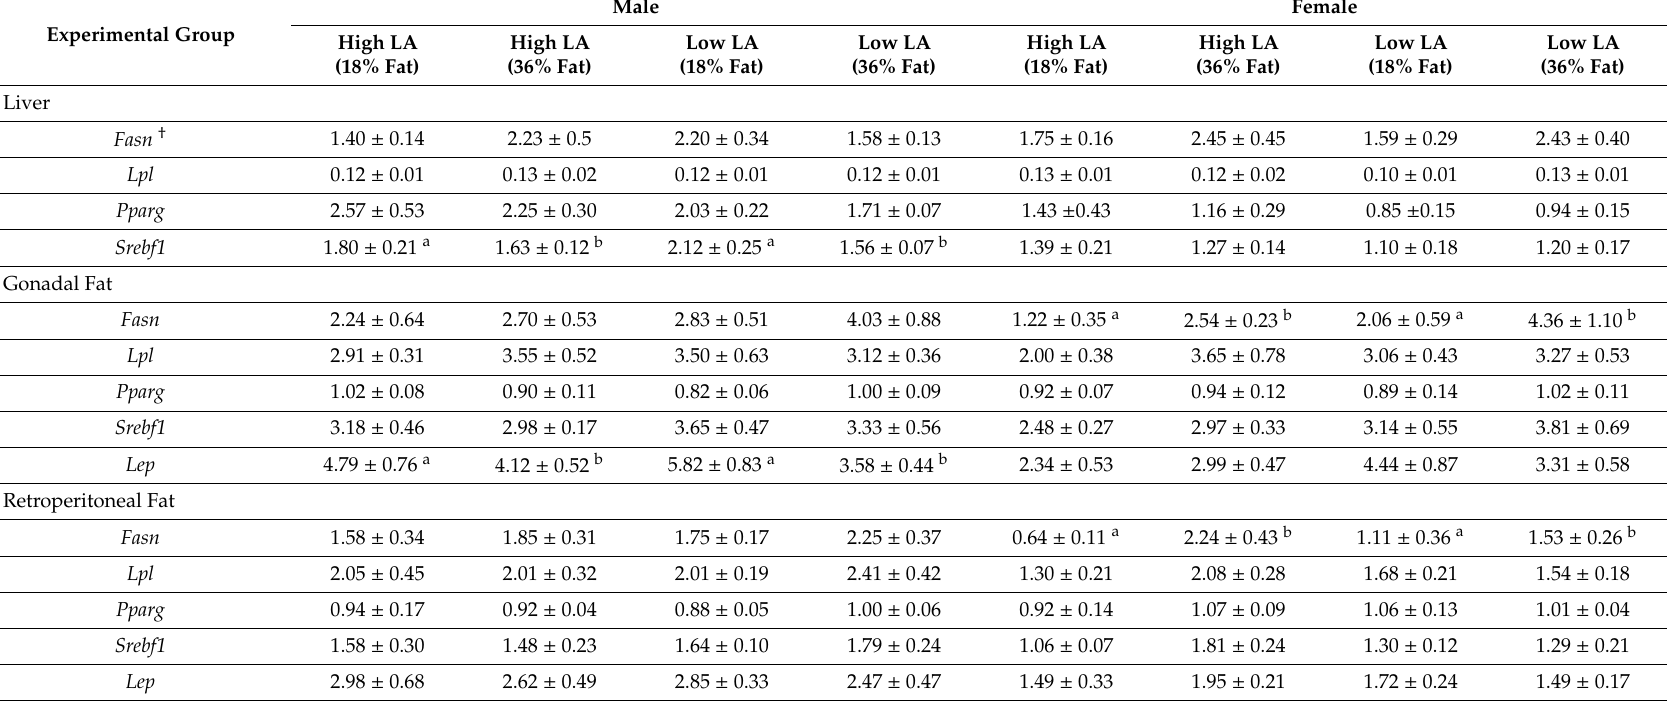
Table 4. O ff spring lipogenic gene expression in male and female o ff spring at 8 weeks of age.